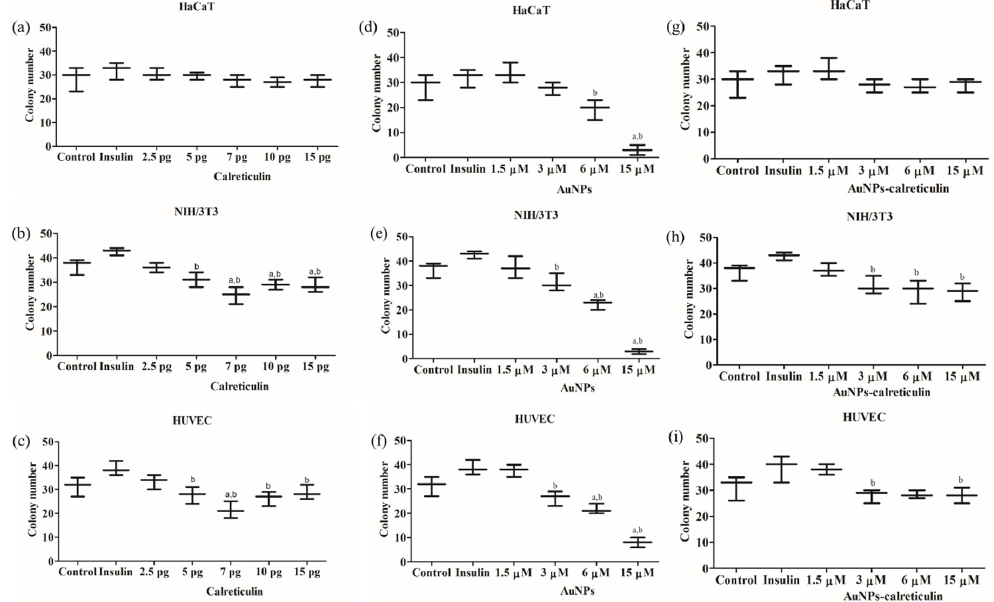
Figure 8. Colony formation. Number of colonies after seven days of treatment with calreticulin ( a – c ), AuNPs ( d – f ), and AuNPs-calreticulin ( g – i ). A significant decrease was observed in the number of colonies in HUVEC and NIH/3T3 cells treated with calreticulin, AuNPs, and